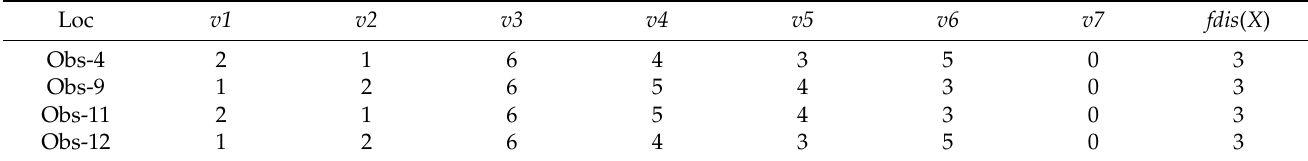
Table 10. Scores of detections for multiple